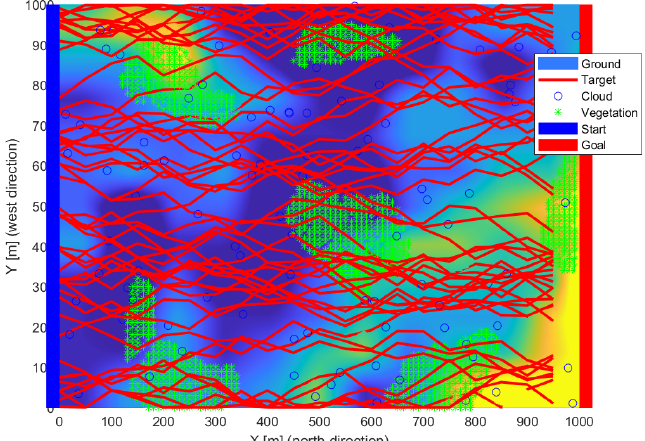
Figure 5. Some of the routes were complex despite the simple